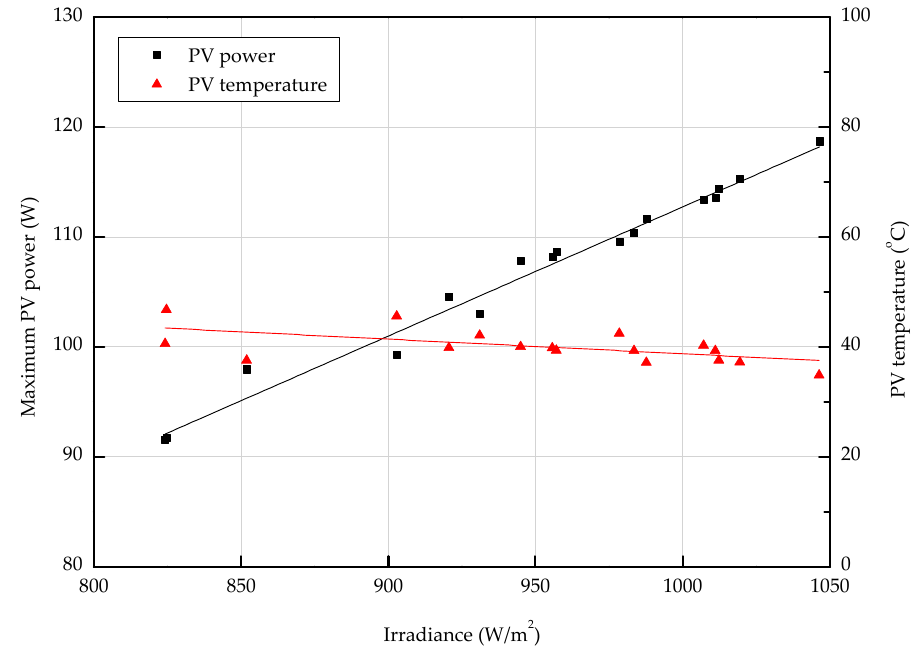
Figure 8. E ff ect of solar radiation on PV power and Figure 8. Effect of solar radiation on PV power and temperature.